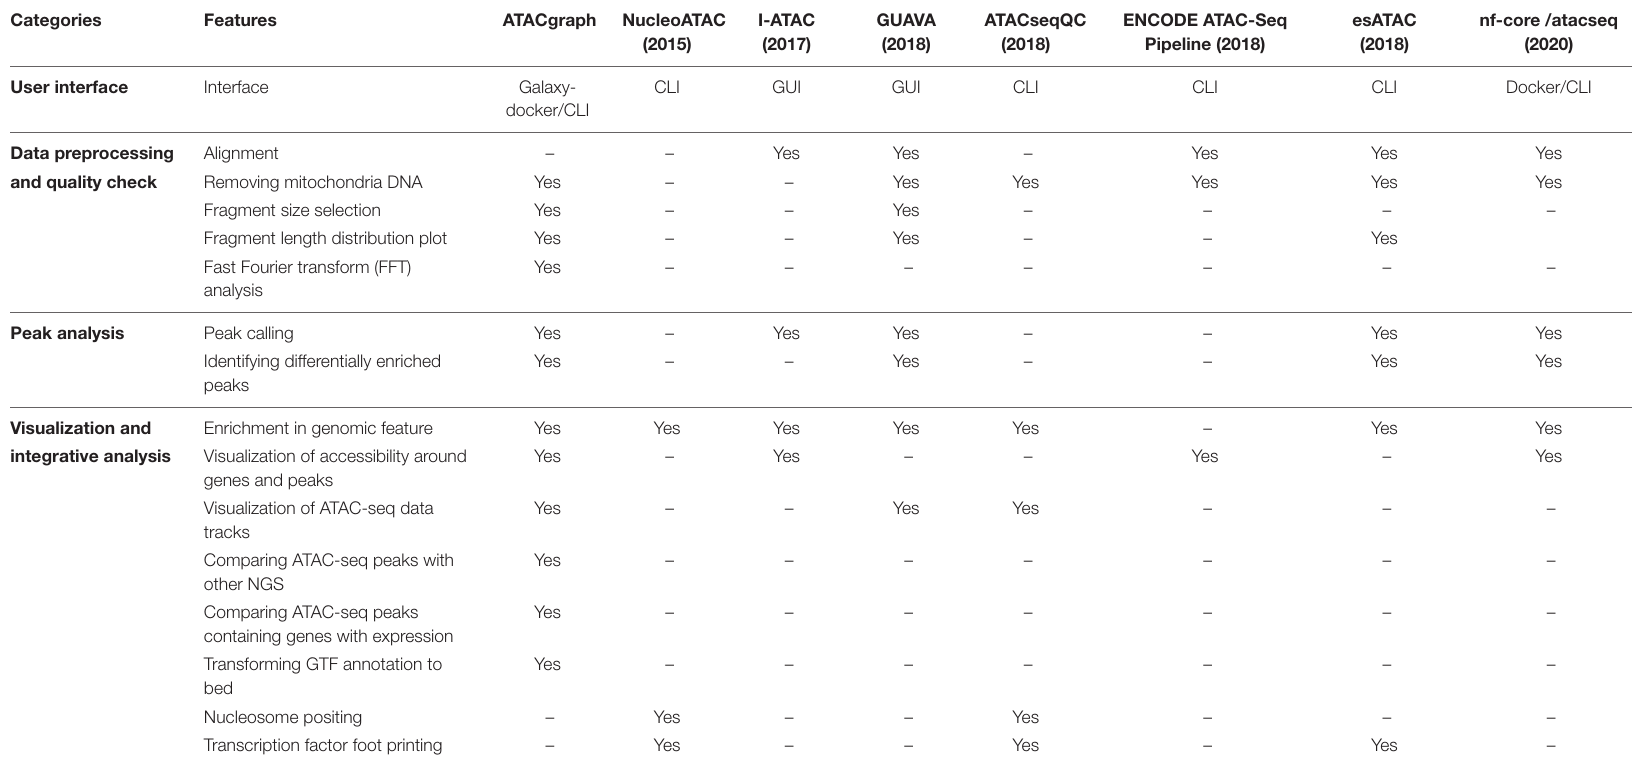
TABLE 1 | Features summary of ATAC-seq bioinformatics